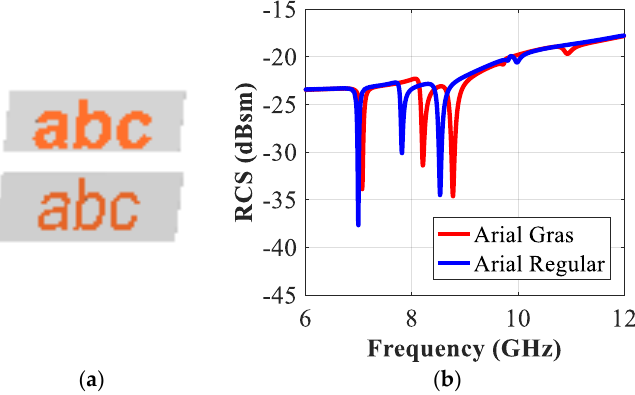
Figure 17. RCS Simulation Results of tag-abc printed by various fonts: ( a ) Different tags written by Arial, Corbel and Time New Roman fonts; ( b ) Co-polar HH RCS responses.